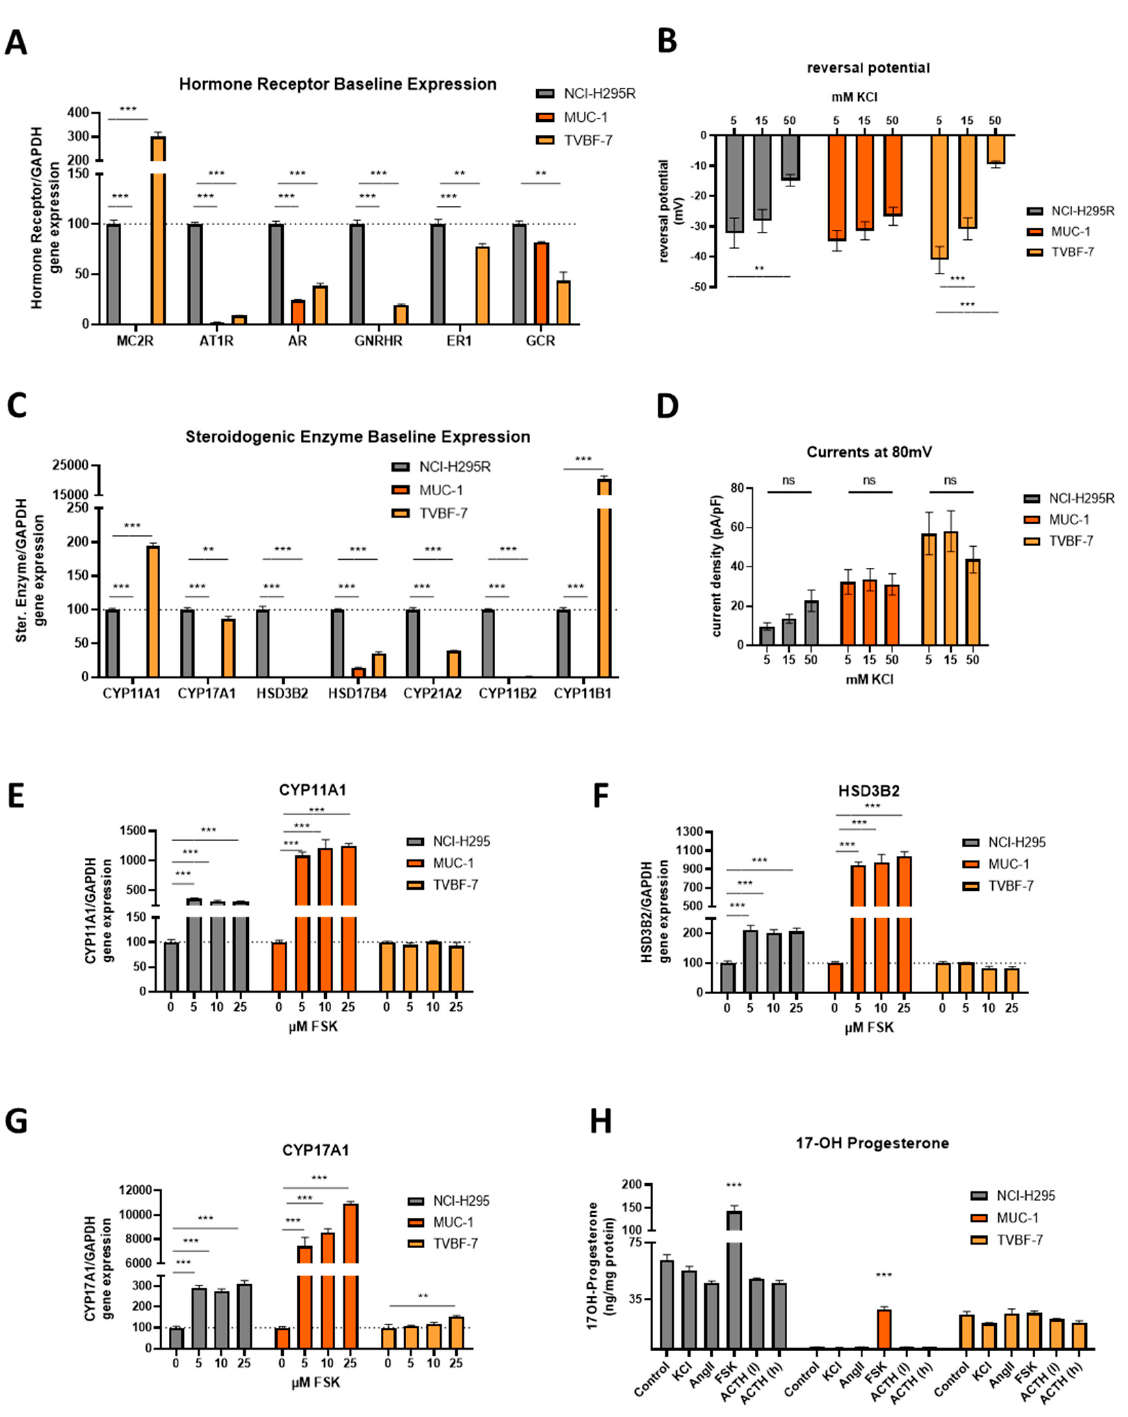
Figure 3. Baseline gene expression levels of different hormone receptors (MC2R, AT1R, AR, GNRH, ER1 and GCR) of unstimulated cells ( A ). Baseline gene expression levels of steroidogenic enzymes (CYP11A1, CYP17A1, HSD3B2, HSD17B4, CYP21A2, CYP11B2 and CYP11B1) ( B ). Comparative depiction of the reversal potential in baseline (5mM KCl) and upon stimulation with total 15 and 50 mM KCl for all